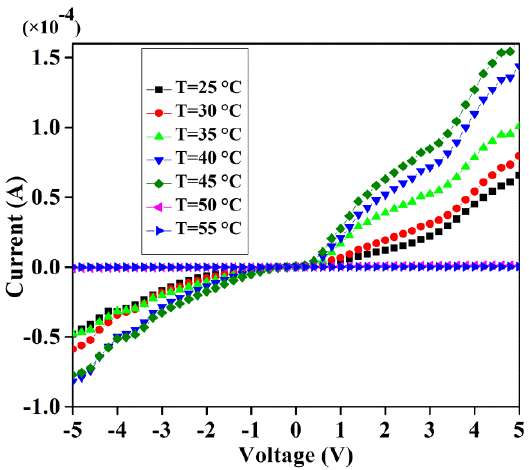
Figure 2. I-V curves of GDG structure at various temperatures in the absence of magnetic